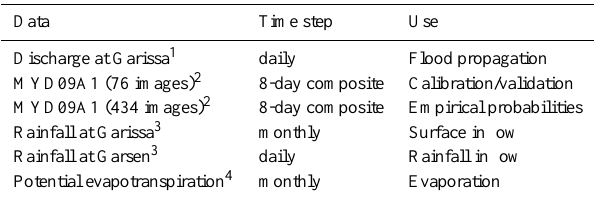
Table 2. Hydrological, climate and remote sensing data used in the Tana Inundation Model